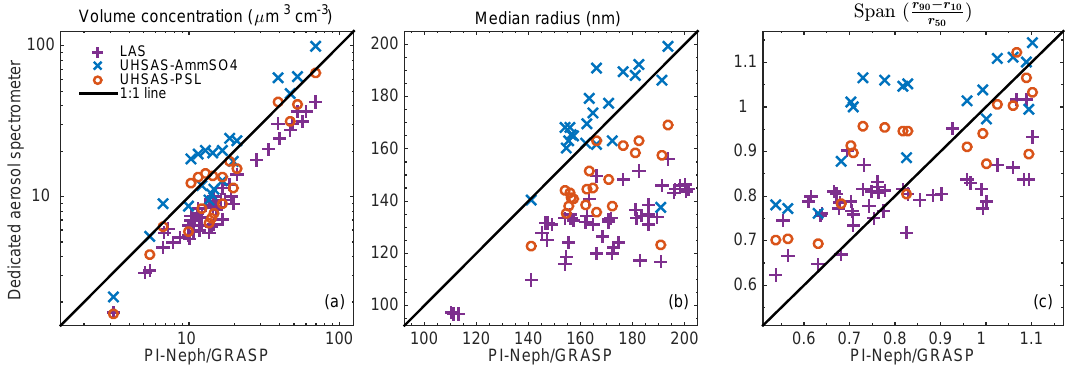
Figure 12. Scatter plot comparisons of retrieved size distributions with particle sizers sampling in parallel to the PI-Neph. In order from left to right the panels show total fine mode (a) volume concentration, (b) volume median radius and (c) span = r 90 PI-Neph measurements is plotted on the horizontal axis while the value measured by the corresponding dedicated aerosol spectrometer is plotted along the vertical axis. The comparisons are made against LAS measurements (purple pluses), UHSAS ammonium-sulfate equivalent optical diameters (blue crosses) and UHSAS PSL equivalent optical diameters (red